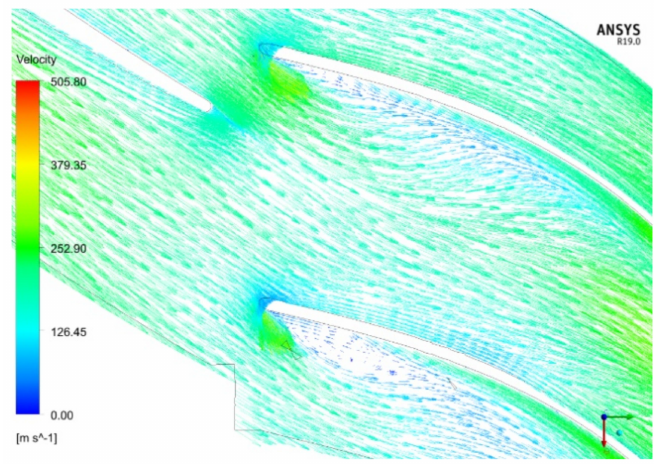
Figure 16. Recirculation on the exducer pressure side, m r =